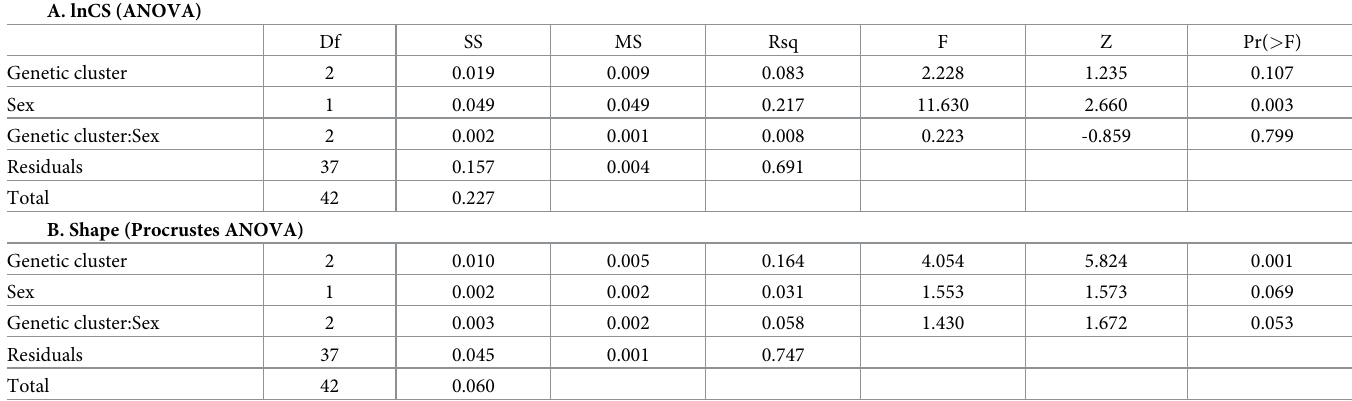
Table 1. Association of A. Skull size (lnCS) and B. Shape, with genetic cluster, sex, and their interaction. Results are based on ANOVA model for size, and Procrus- tes ANOVA for shape. A. lnCS (ANOVA)